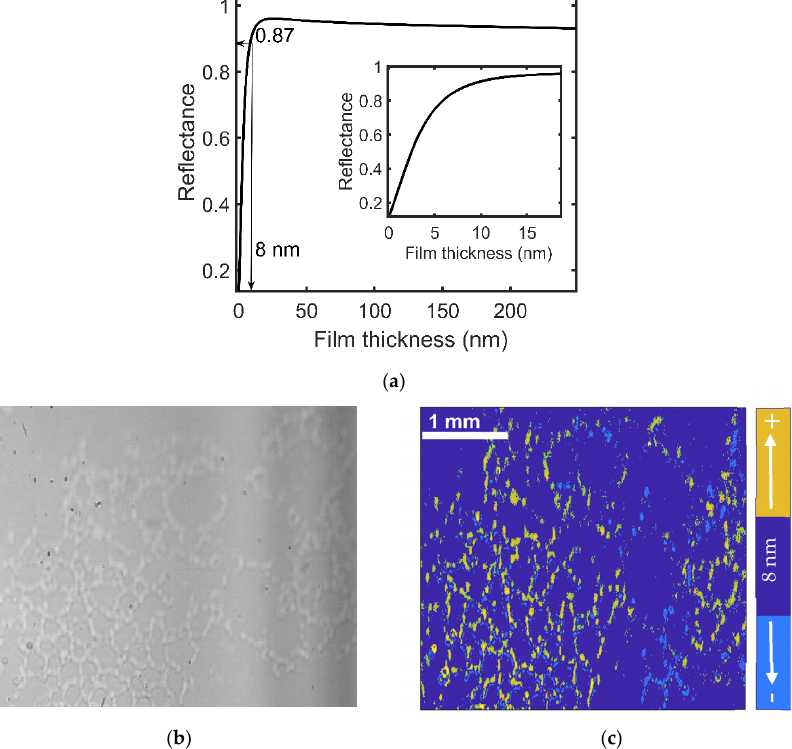
Figure 7. ( a ) Theoretical correlation between the reflectance and thickness of the water film, as visualized using SPRi at an experimental angle of 43.15 degrees and a wavelength of 680 nm, ( b ) a raw image of a thin film between droplets during USDC (bright and dark grays represent thin films and droplets, respectively), and ( c ) the corresponding processed image of thin films grown between droplets during USDC (dark blue, light blue, and yellow colors represent droplets, film with thickness smaller than 8 nm, and film with thickness larger than 8 nm, respectively).